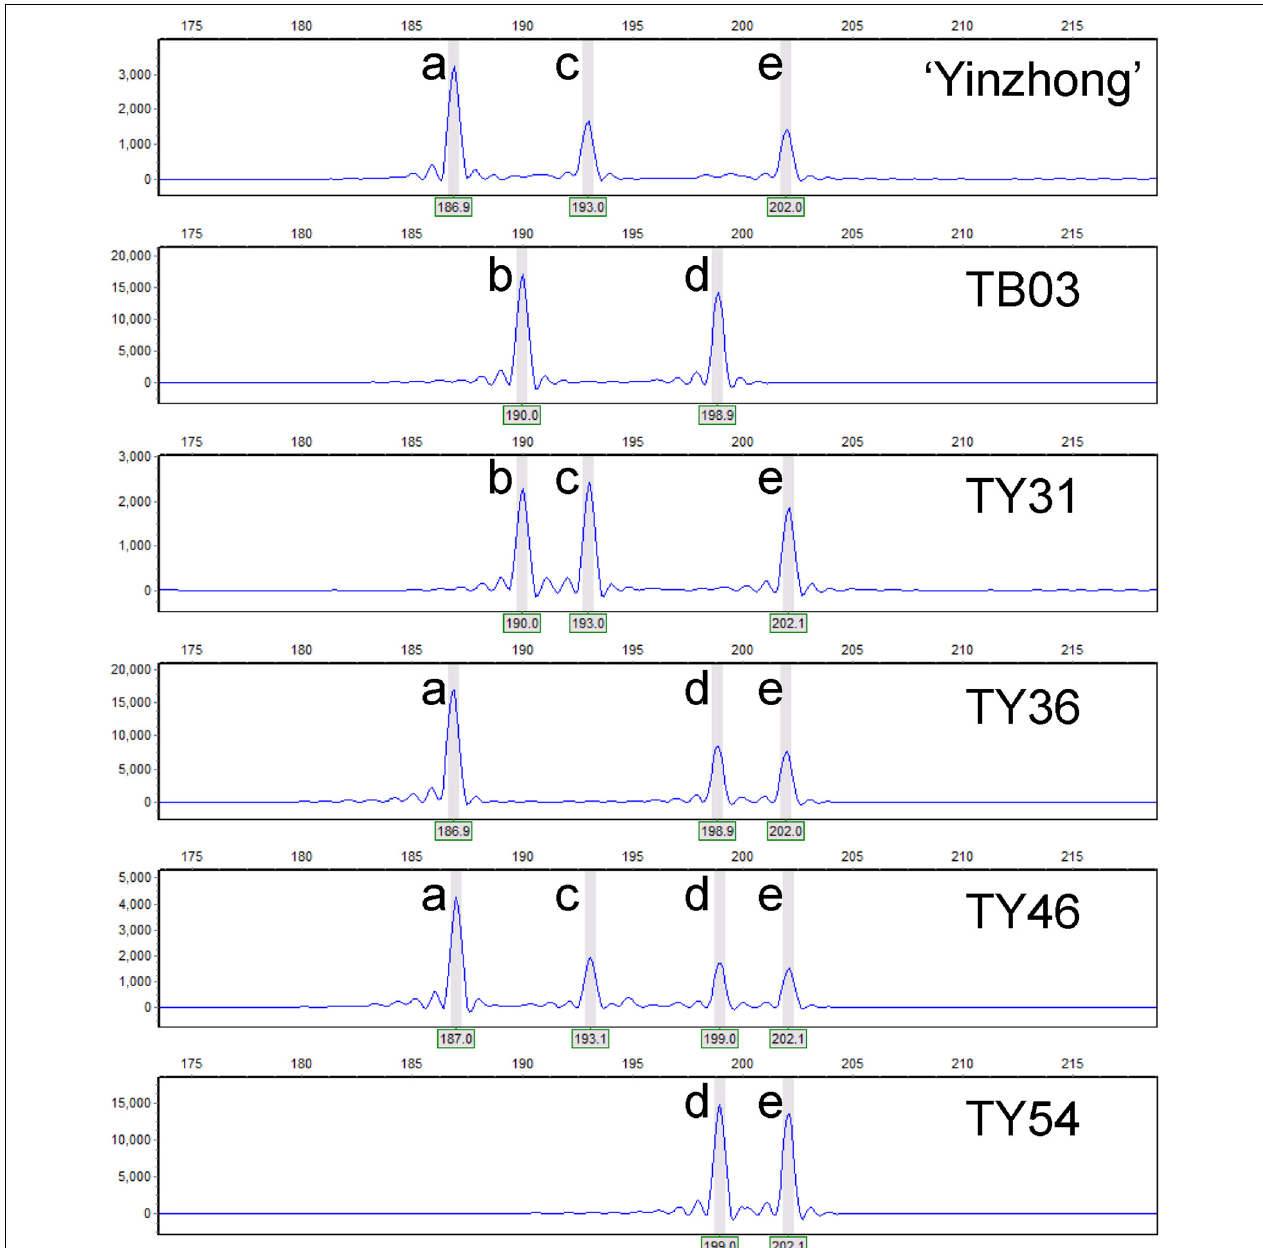
FIGURE 2 | Genotypic analyses of the parents and parts of progeny based on capillary electrophoresis of locus Pop-11-3271. Letters a–e represent the alleles at the locus Pop-11-3271.